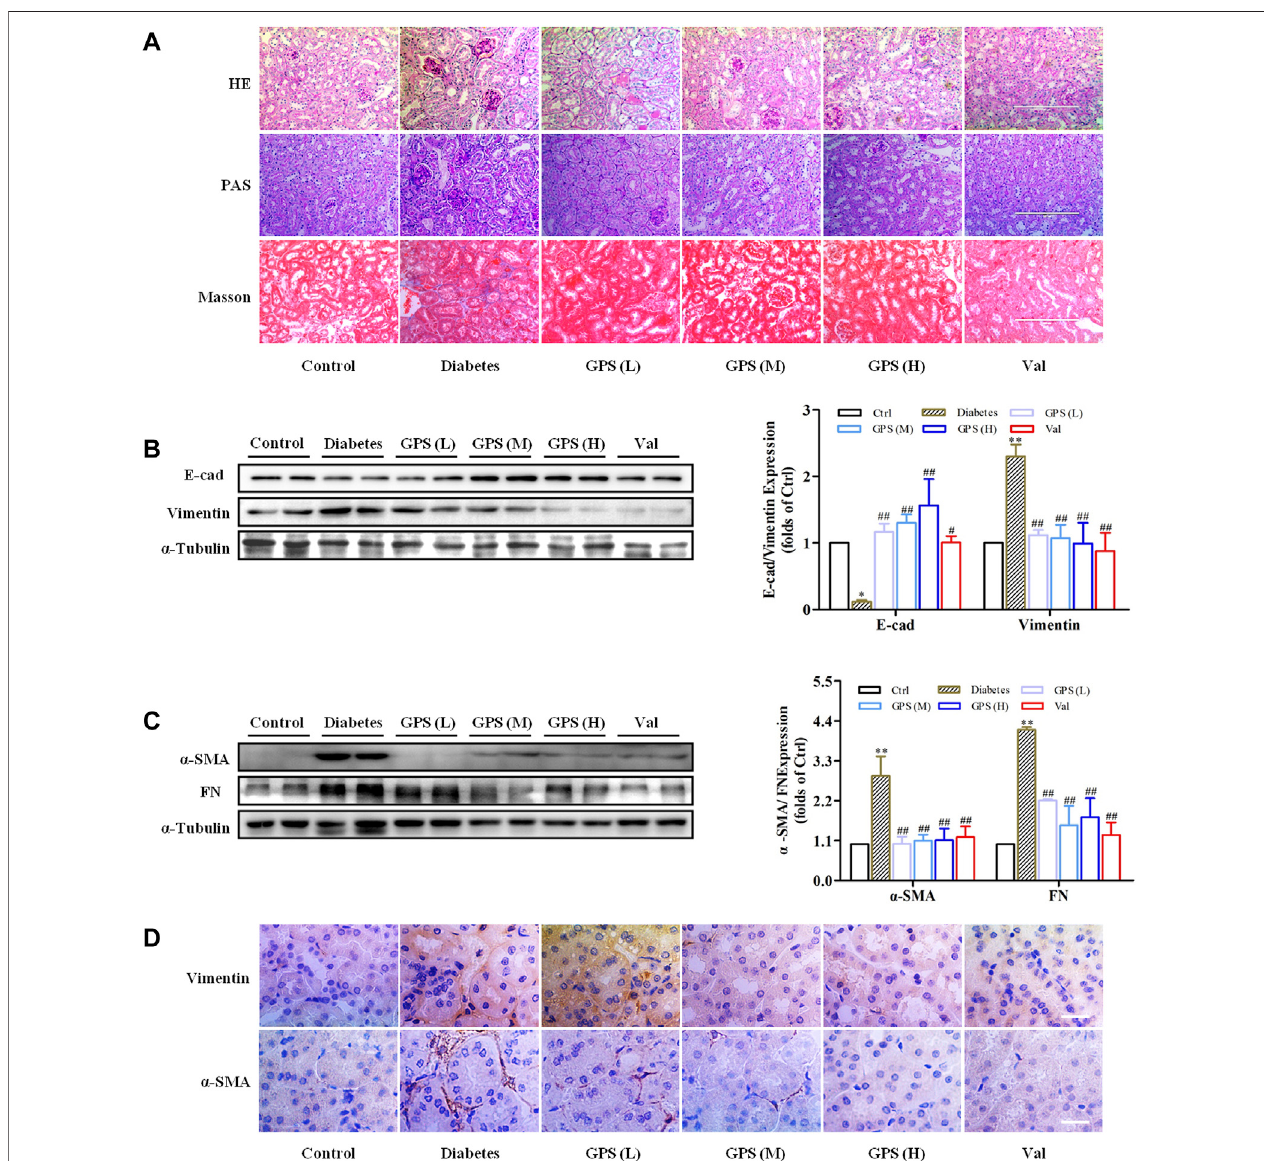
FIGURE 2 | GPS treatment ameliorated renal fi brosis of diabetic mice. (A) Histopathology analysis of renal tubules by HE (scale bar: 200 μ m), PAS (scale bar: 200 μ m), and Masson (scale bar: 200 μ m) staining. (B,C) Protein levels of E-cad, vimentin, α -SMA, and FN in renal tissues of diabetic mice were detected by Western blot. (D) Protein levels of vimentin and α -SMA in renal tubules of diabetic mice were detected by immunohistochemistry. Scale bar: 25 μ m. Data were expressed as mean ± SD. n = 8. ** p < 0.01 vs . Ctrl. ## p < 0.01 and # p < 0.05 vs . diabetes.